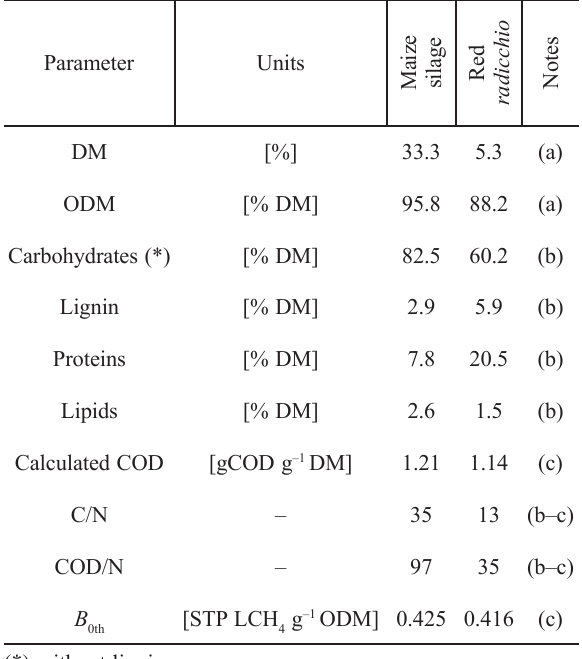
Table 2 – Characteristics of tested substrates